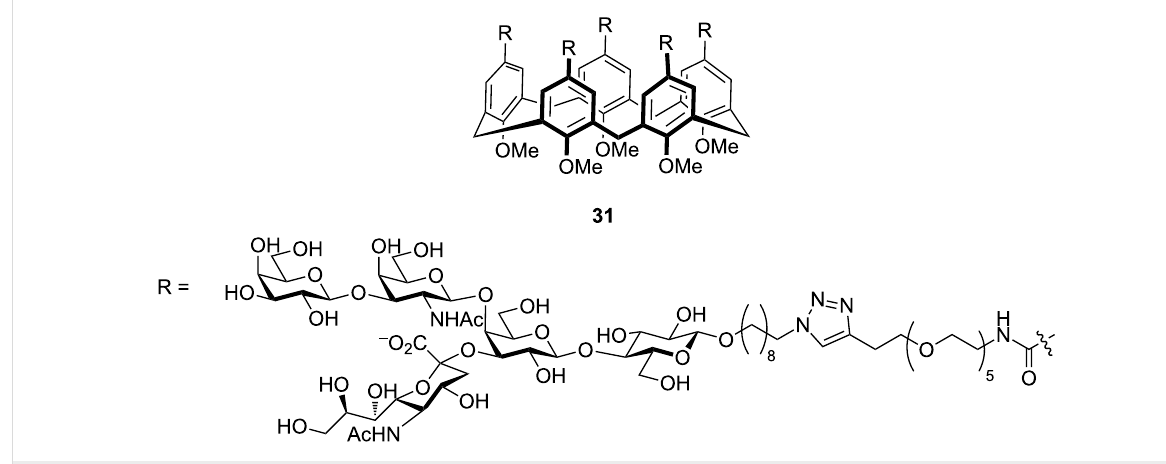
Figure 12: Calix[5]arene core-based pentavalent inhibitor designed by Garcia-Hartjes et al.